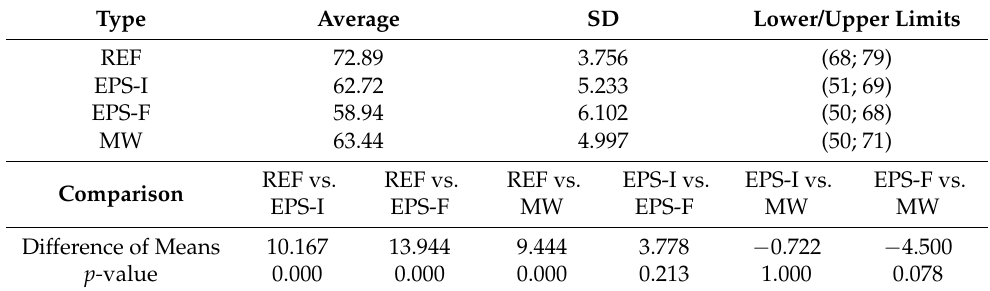
Table 13. Statistical analysis for the surface hardness tests (Ud. Shore D) in each group of mortar and its